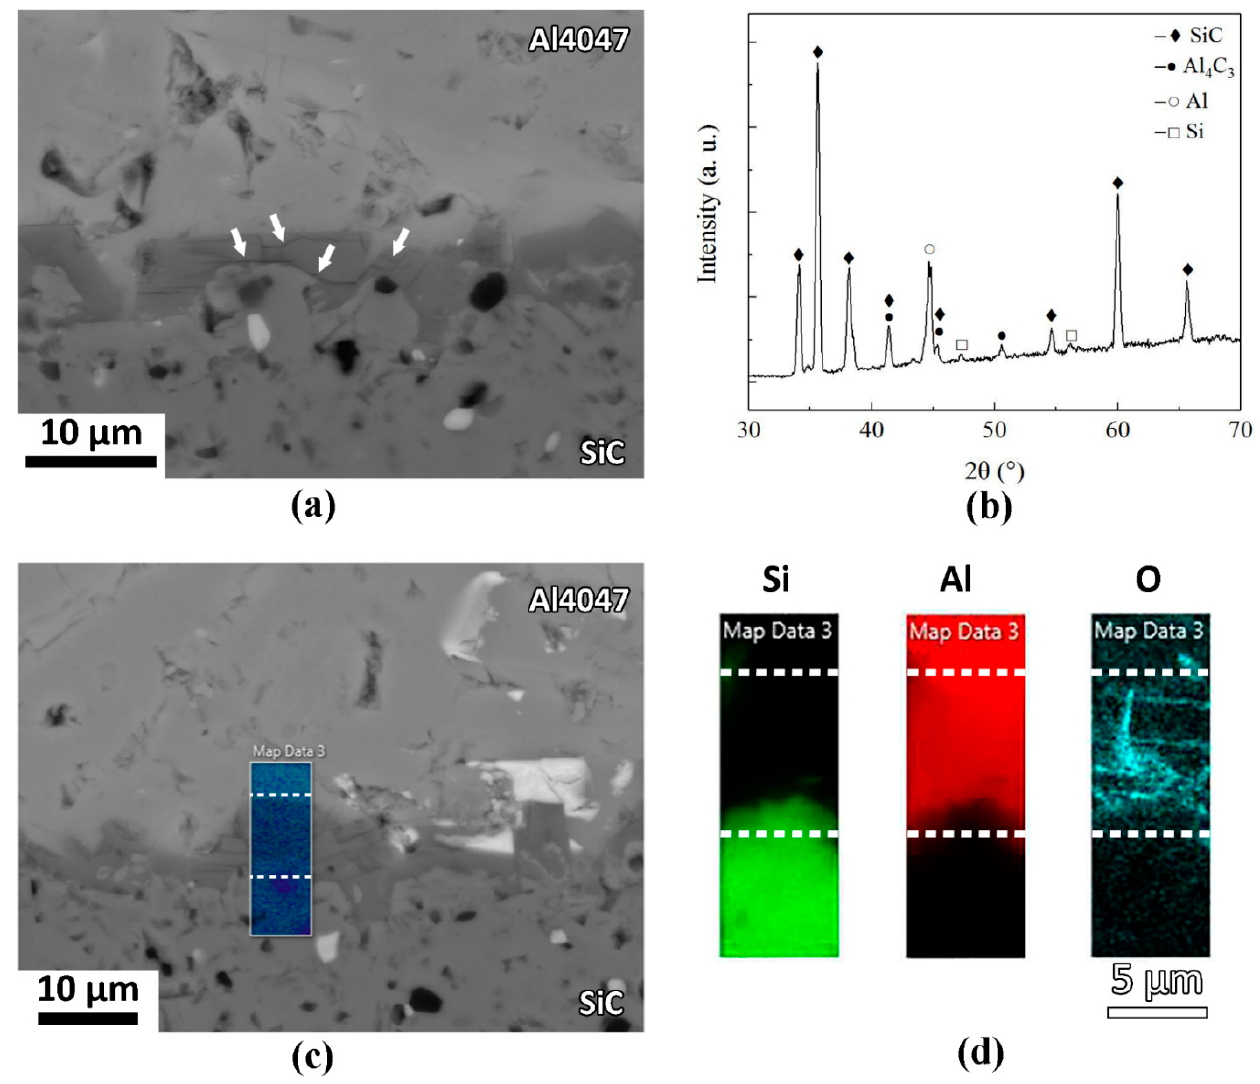
Figure 5. ( a ) Backscattered electron micrograph of Al4047/SiC joint showing interfacial layer and microcracks (arrowed) in the layer; ( b ) XRD pattern of Al4047/SiC joint; ( c ) SEM image showing the rectangular area for EDS in the Al4047/SiC joint; and ( d ) corresponding EDS mapping results of the area in ( c ). (The white dashed lines denote the reaction layer in the interfacial area).